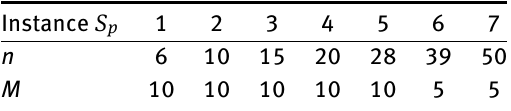
Table 2: Characteristics of MKNAP 1 problem